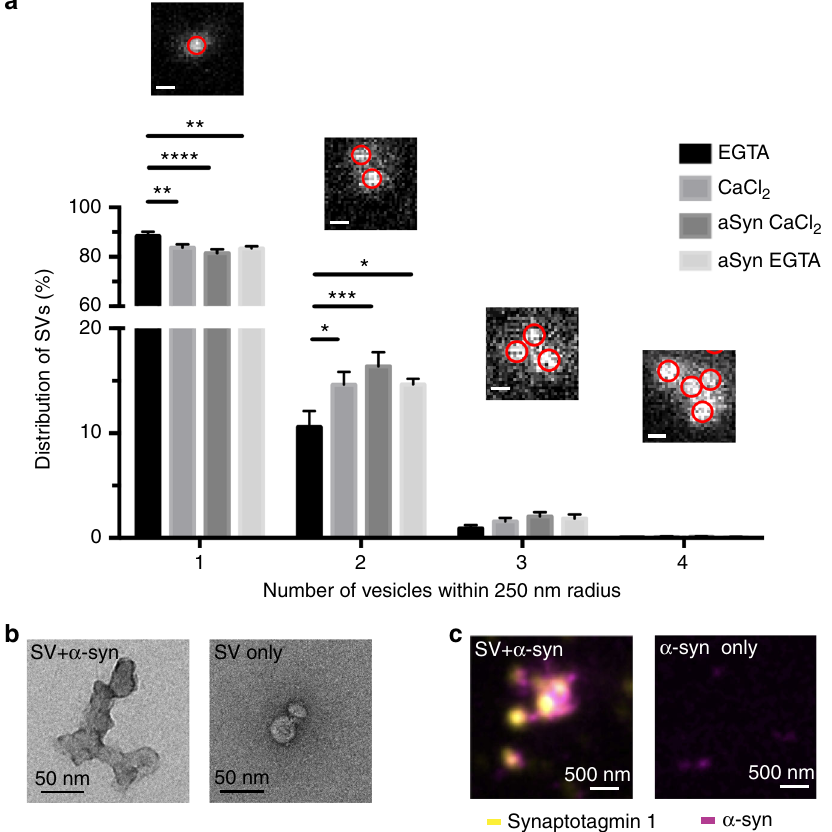
Fig. 3 Alpha-synuclein and calcium balance the interaction of synaptic vesicles. a STED super-resolution imaging of isolated synaptic vesicles incubated with 1 mM EGTA, 200 µ M calcium, 50 µ M alpha-synuclein + 200 µ M calcium, or 50 µ M alpha-synuclein + 1 mM EGTA. Images show synaptic vesicles circled in red as detected for analysis of synaptic vesicle clustering. Scales represent 200 nm. Synaptic vesicle clustering is shown as a decrease of synaptic vesicles found as single vesicles and as an increase of synaptic vesicles found in clusters was seen upon incubation of synaptic vesicles with either increased calcium or alpha-synuclein. Note, EGTA was not able to reduce synaptic vesicle clustering in the presence of increased alpha-synuclein concentrations. ** p = 0.0023, **** p < 0.0001, and ** p = 0.0012 for comparison of % of single vesicles, * p = 0.0140, *** p = 0.0001, and * p = 0.0136 for comparison of % of vesicle clusters of two. Calculated using two-way ANOVA with Tukey ’ s post-hoc correction, graphs indicate mean ± s.e.m. N = 18 for all conditions, data from three biological repeats, d.f. 272. b TEM images of synaptic vesicles showing synaptic vesicle clustering in the presence of 50 µ M alpha-synuclein. c Combined imaging of synaptic vesicles (confocal) and ATTO-647N-labeled alpha-synuclein (STED) showing synaptic vesicles surrounded and glued together by alpha-synuclein. Two biological